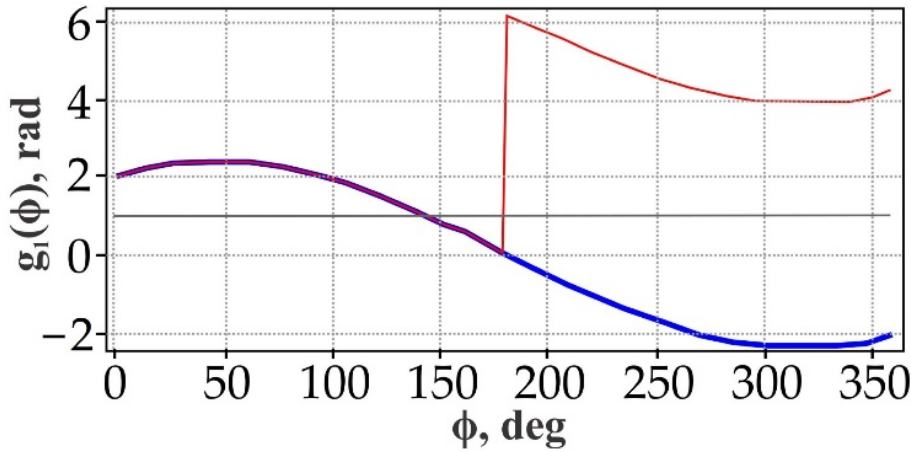
Figure 1. Function g 1 ( ϕ ): original function (blue curve) and function reduced to positive values (red curve).